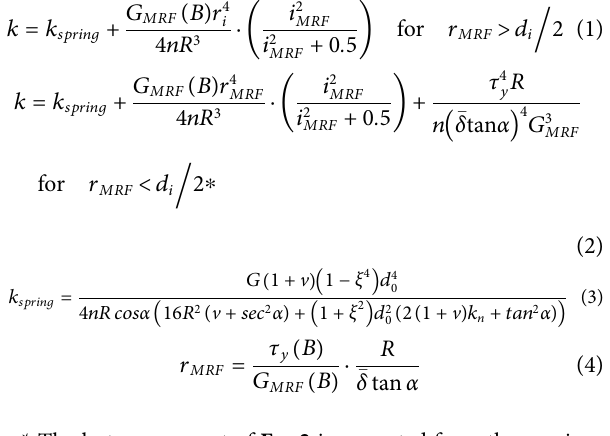
(cid:129) Frequency. As the post-yield plastic viscosity, η , of MR fl uid